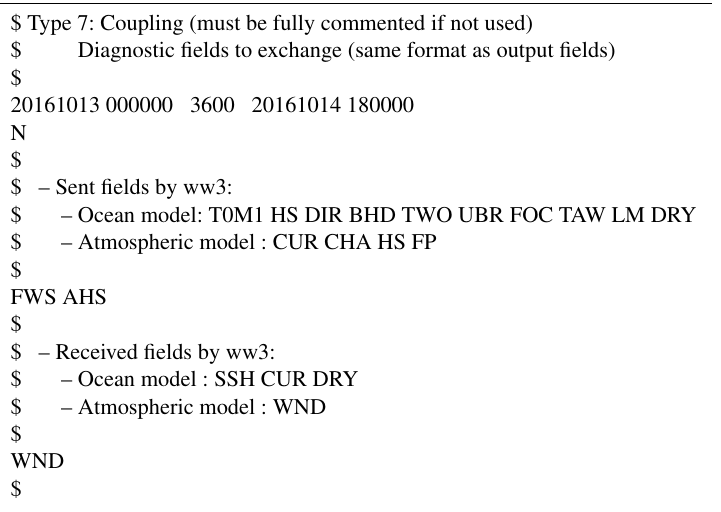
Table A2. Part dedicated to coupling in the WaveWatch3 namelist (ww3_shel.inp) for the forecast starting on 13 October 2016 00:00UTC (AOW